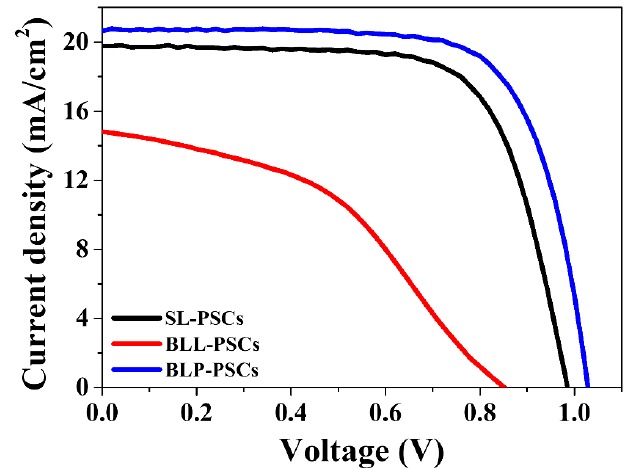
Figure 4. Reverse scan current density–voltage (J-V) curves of SL-PSCs, BLL-PSCs, and BLP-PSCs. Table 1. Summary of the photovoltaic parameters of PSCs based on different